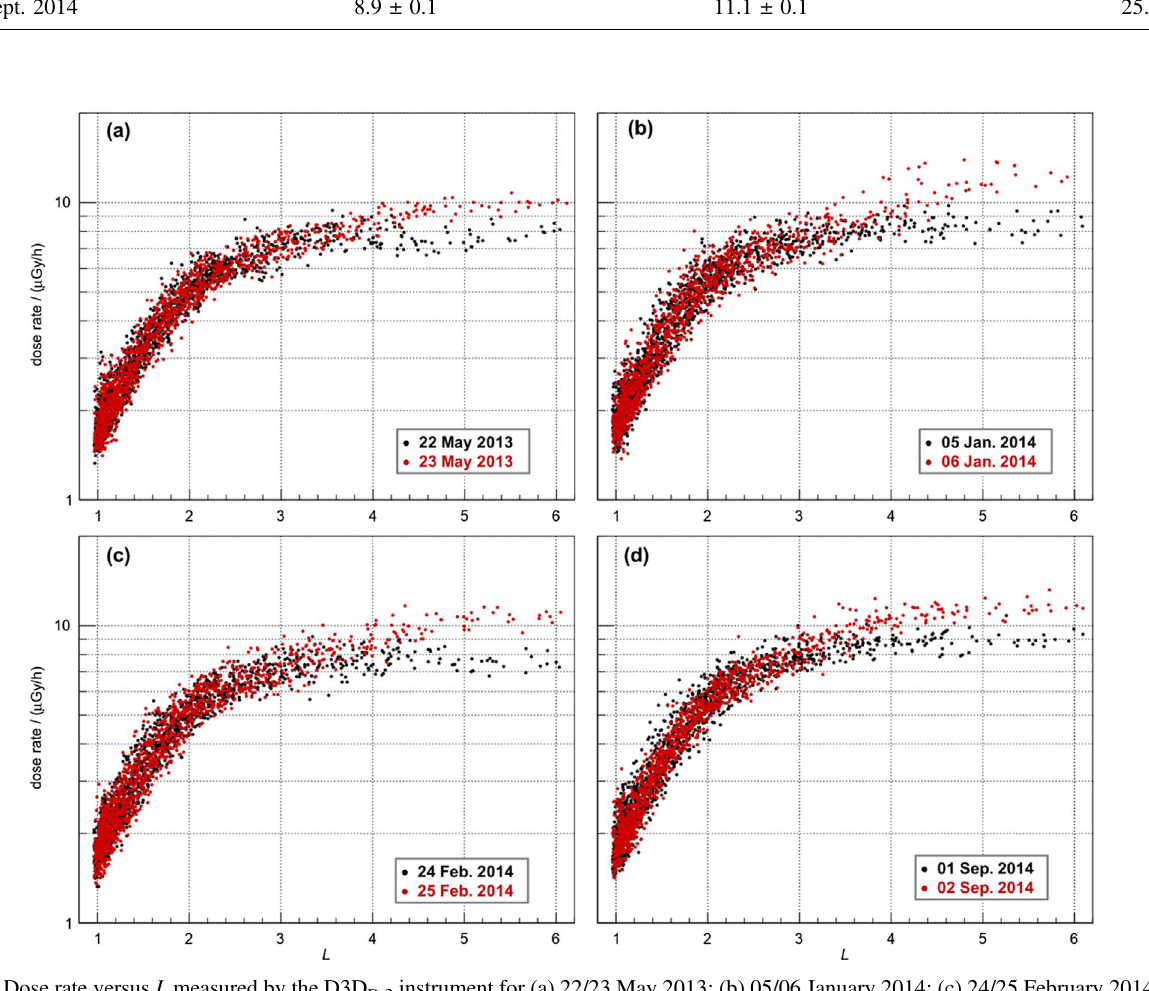
Fig. 11. Dose rate versus L measured by the D3D D-2 instrument for (a) 22/23 May 2013; (b) 05/06 January 2014; (c) 24/25 February 2014; and (d) 01/02 September 2014. Note: Pre-event data are given in black and event data in red (see also Table 5).